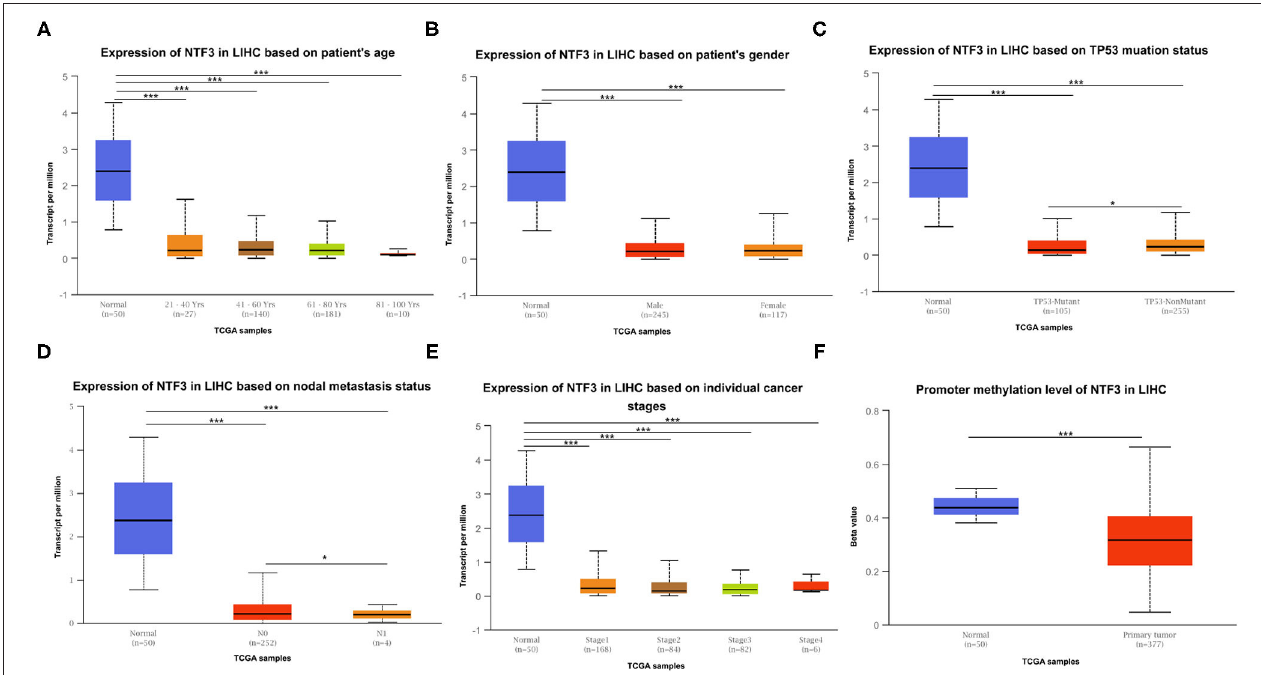
FIGURE 2 | NTF3 mRNA expression varies in various subgroups of liver cancer patients based on patient age, patient sex, nodal metastasis status, cancer stage, TP53 mutation status and promoter methylation level (UALCAN). (A) Boxplot shows the relative expression of NTF3 in different age groups of liver cancer patients. (B) Boxplot shows the relative expression of NTF3 in different gender groups of liver cancer patients. (C) Boxplot shows the relative expression of NTF3 in the TP53 mutation status group of liver cancer patients. (D) Boxplot shows the relative expression of NTF3 in the nodal metastasis status group of liver cancer patients. (E) Boxplot shows the relative expression of NTF3 in the cancer stage group of liver cancer patients. (F) Boxplot shows the relative expression of NTF3 in the promoter methylation level group of liver cancer patients. Data are mean ± SE. * , P < 0.05; *** , P < 0.001.